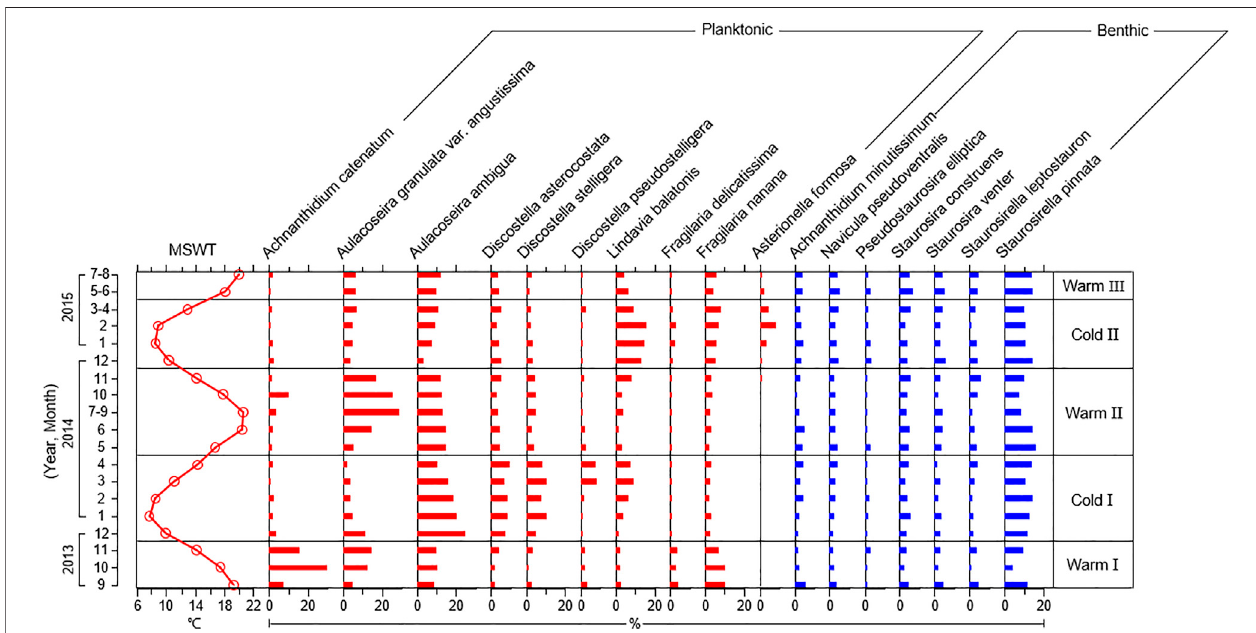
FIGURE2| Changesinthemean relativeabundanceofthemaindiatomspeciesfromdiatomseasonalinvestigation ofYunlongLake. MSWT representsthemean surfacewatertemperatureatdepthsof1,5and 7m.Threewarmandtwocoldseasonsarede fi nedbychangesinmonthlyaveragewatertemperatureatthefourdepths within the water column (Zou et al.,